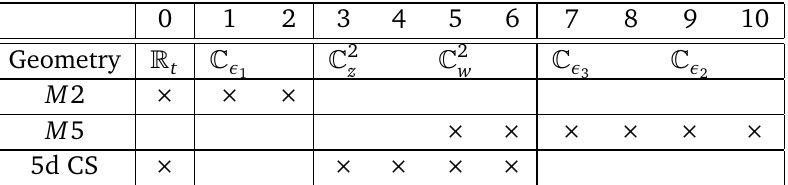
× (cid:67) and M 5 branes may extend over (cid:67) ε t i